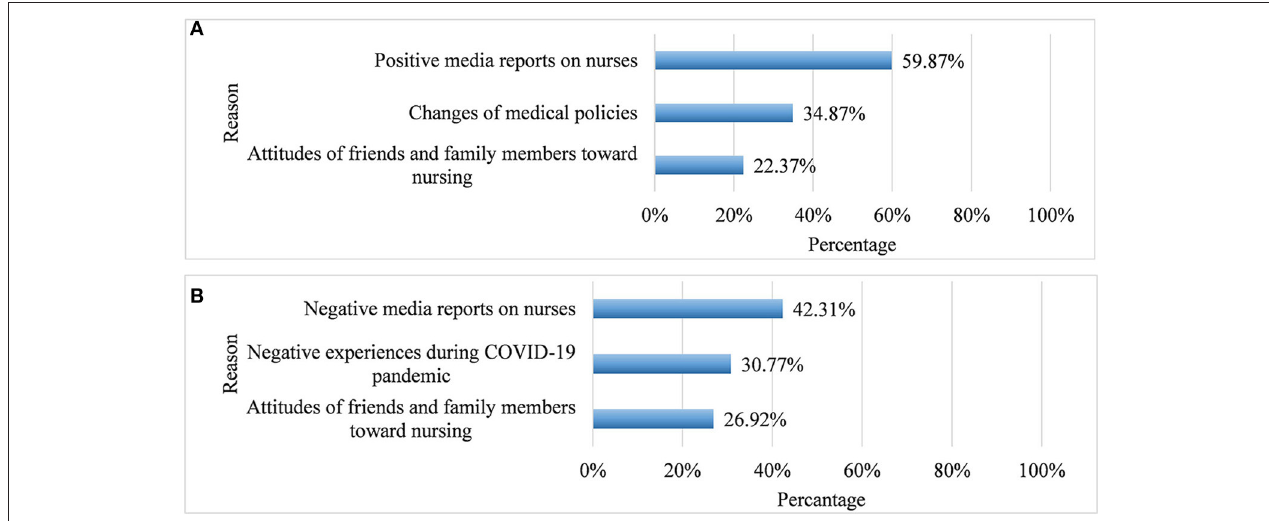
FIGURE 1 | Causes of career choice change. (A) Career choice change from “not choosing nursing before COVID-19 pandemic” to “choosing nursing after COVID-19 pandemic” ( N = 152). (B) Career choice change from “choosing nursing before COVID-19 pandemic” to “not choosing nursing after COVID-19 pandemic” ( N = 26).